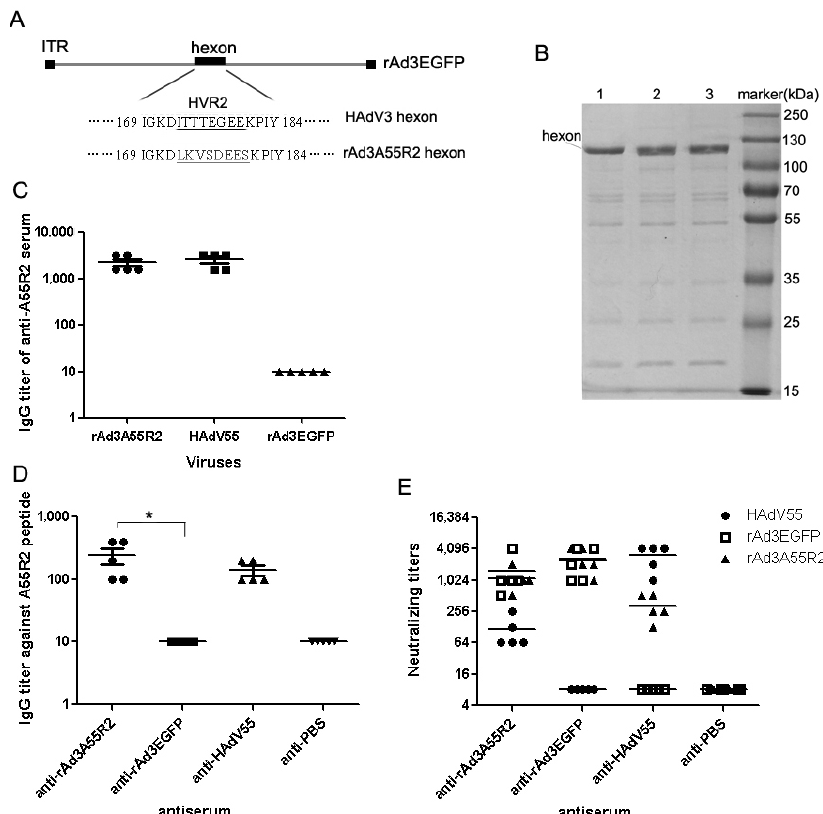
Figure 4. The antigenicity of the epitope chimeric recombinant rAd3A55R2. ( A ) Schematic depiction of rAd3A55R2 replacing HVR2 of rAd3EGFP with A55R2. HVR2 amino acid sequences of HAdV3 and HVR2 amino acid sequences of HAdV55 incorporated in rAd3A55R2 hexon are shown with underline; ( B ) Recombinant rAd3A55R2 confirmation by SDS-PAGE, 1 : HAdV55, 2 : rAd3A55R2, and 3 : rAd3EGFP virions; ( C ) ELISA with anti-A55R2 sera as primary antibody with purified rAd3A55R2 and HAdV55, rAd3EGFP virions; ( D ) ELISAs of the anti-rAd3A55R2 sera with synthetic peptide A55R2. The anti-HAdV55 and anti-rAd3EGFP were used as the controls; ( E ) In vitro neutralization tests. Neutralization tests were performed with the anti-rAd3A55R2 sera against HAdV55 and rAd3EGFP. The anti-HAdV55 and anti-rAd3EGFP sera were used as the controls. Each experiment was repeated independently at least three times. Each symbol represented a mouse, and the lines indicated the means or means ± SEM. * p < 0.05.